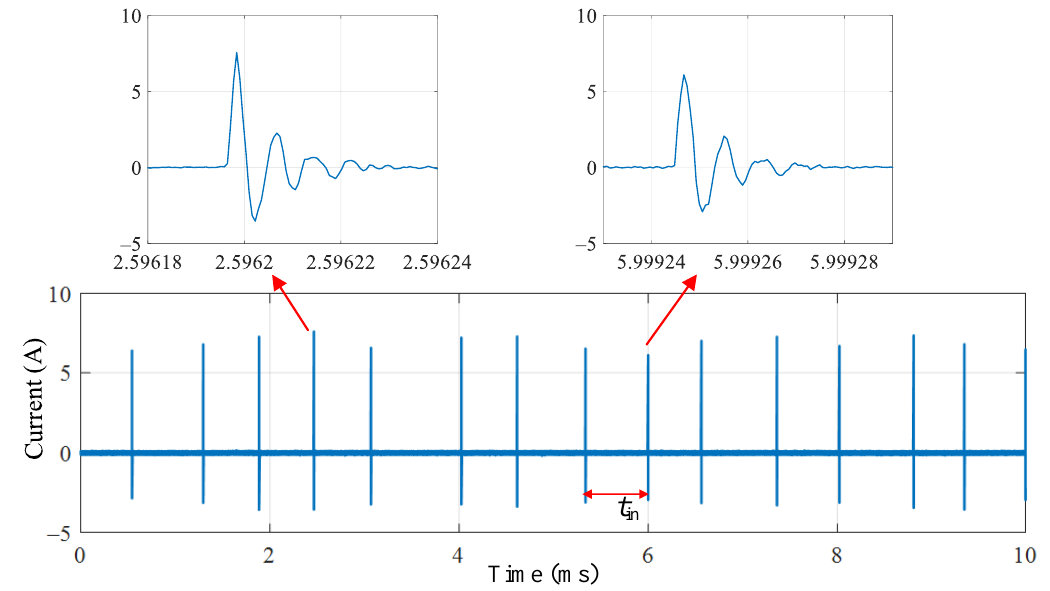
Figure 4. Current waveform of a repeating pulse train over 10 ms acquisition period.